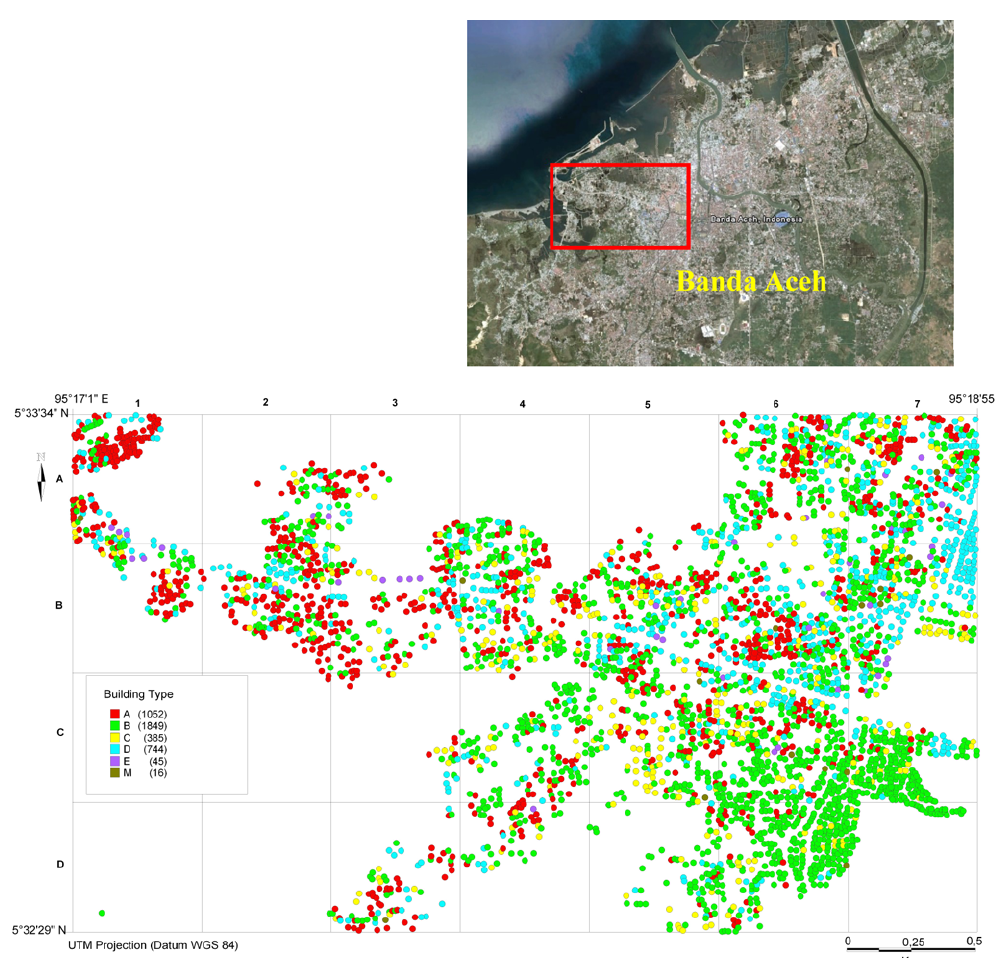
Fig. 1. Map showing the extended database of buildings in Banda Aceh, Indonesia, classified according to their vulnerability (“A” being the most vulnerable, made of wood, single storey, and “E” the most resistant, well designed, made of reinforced concrete with columns and infill walls. “M” stand for Mosque). The total number of buildings per type is given into